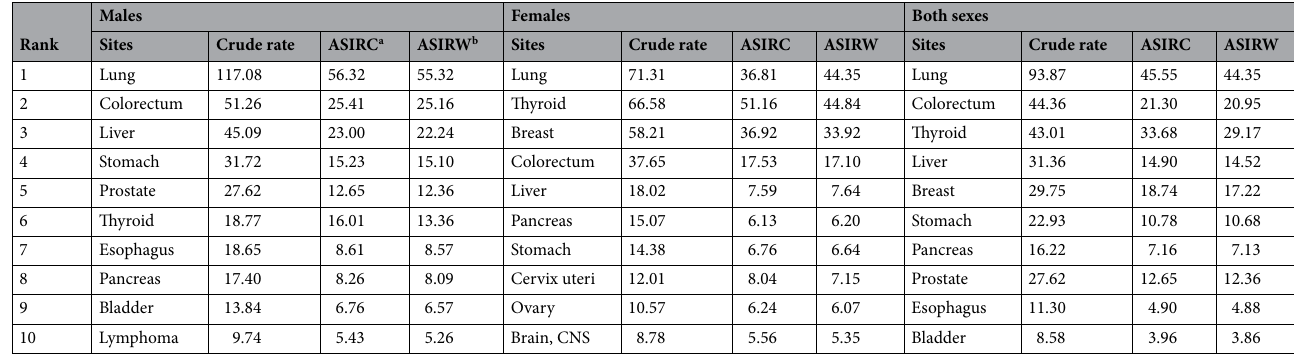
Table 10. The rank of cancer incidence around Qinshan NPP from 2012 to 2020 (1/100,000). a Age- standardized incidence rate by Chinese 2000 standard population. b Age-standardized incidence rate by WHO 2000 standard population.